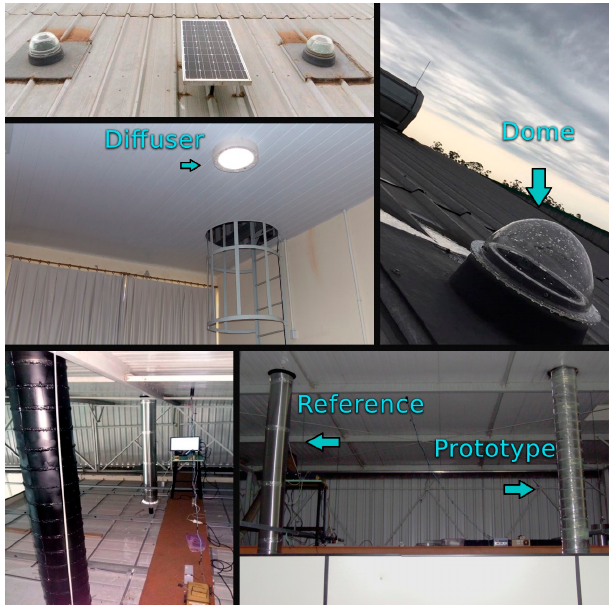
Figure 6. Validation rooms.